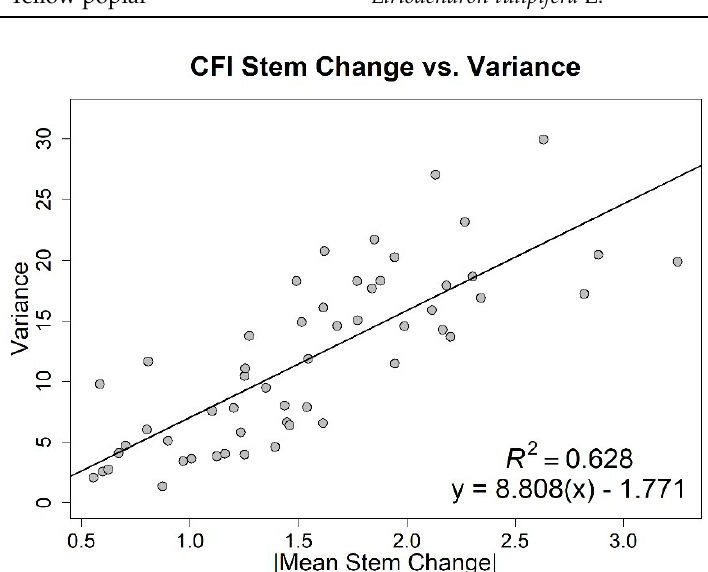
Figure A1. Plot of Vegetation Impact Protocol (VIP) absolute value mean stem change and sampling variance for 19 state forest districts across 3 sampling periods. The best-fit linear trendline is plotted and the regression equation is also listed.